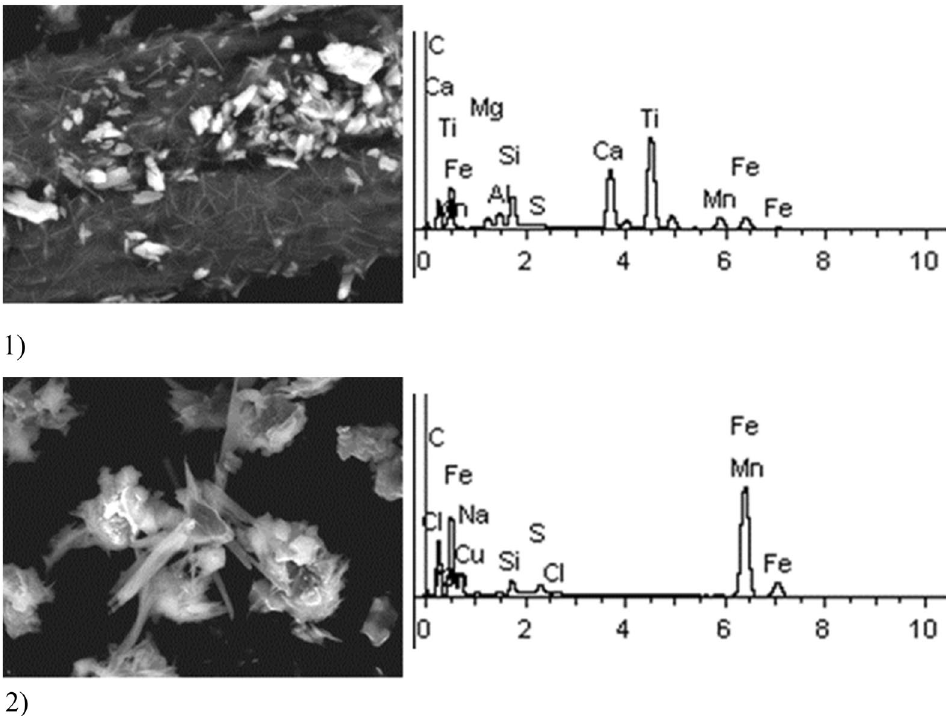
Figure 6. Sulfuric acid anodizing. Particles morphology. Scanning electronic microscopy.